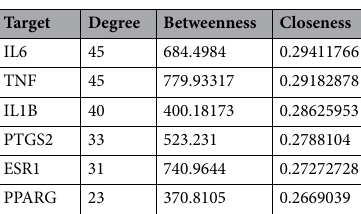
Table 2. Topological analysis of PPI